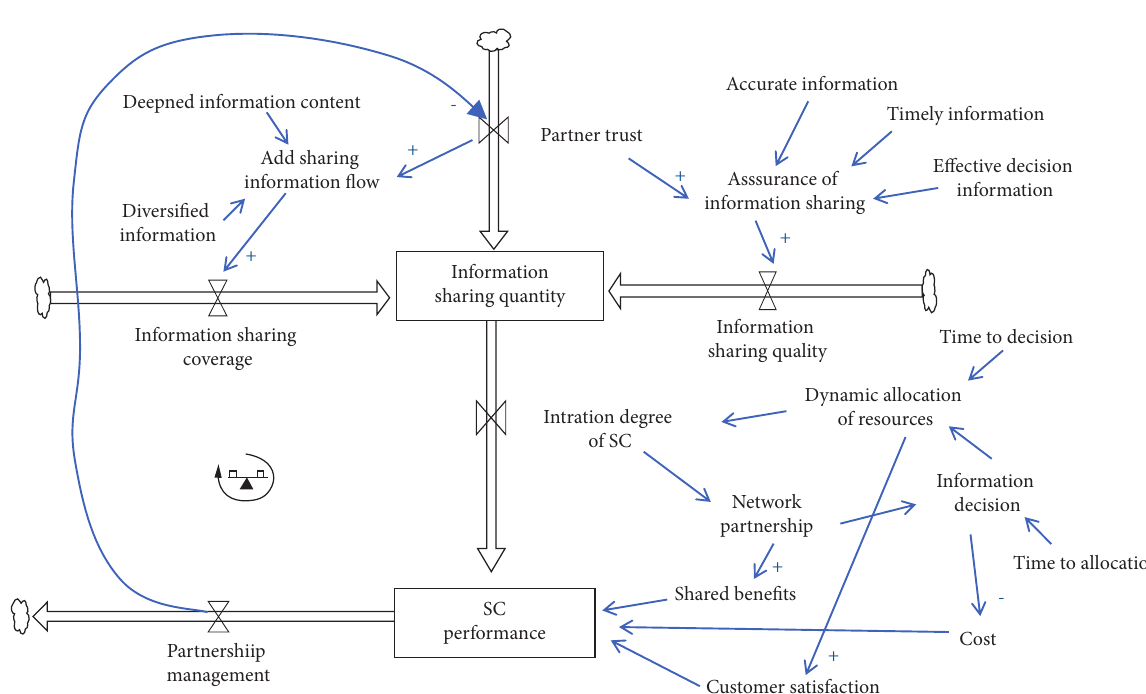
Figure 2: Venism-based model for IS influences on SC